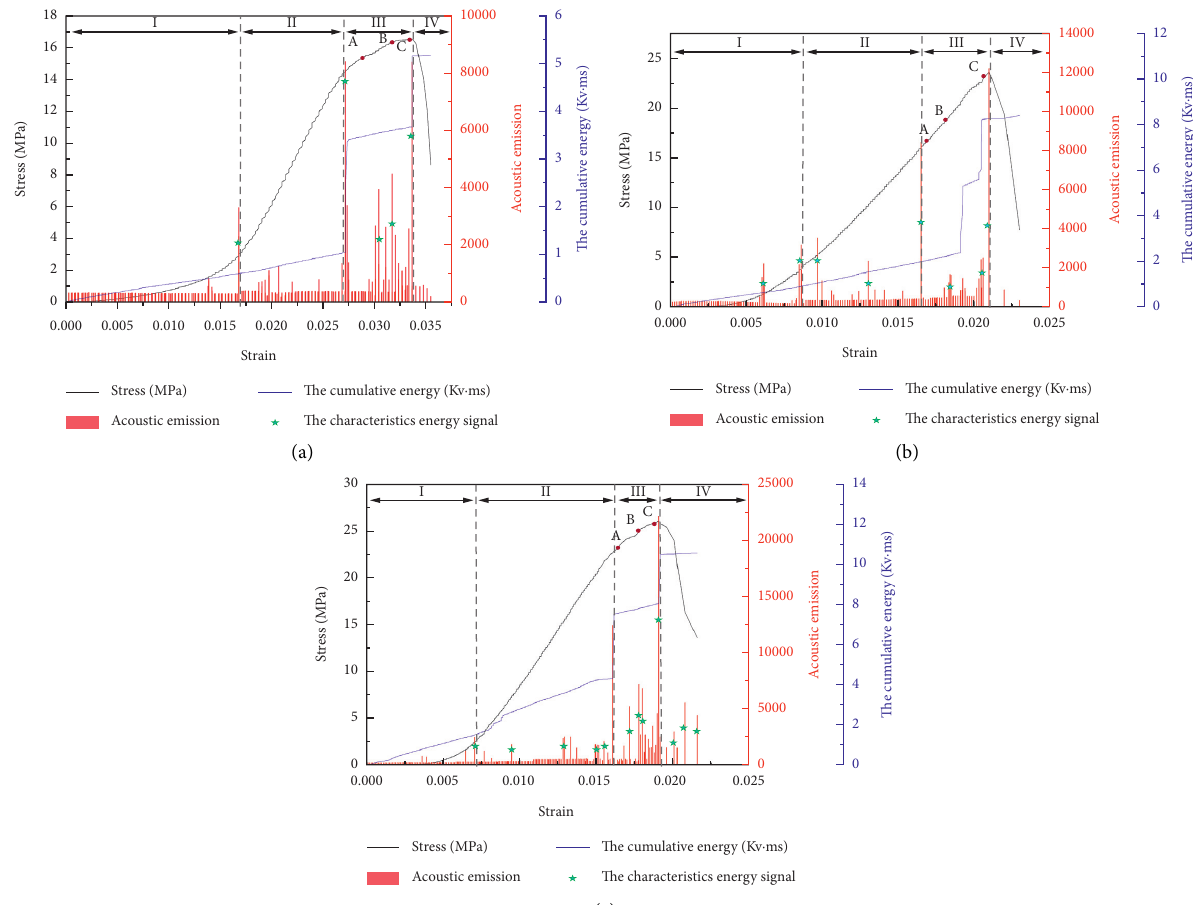
Figure 3: Different coal mass stress-strain and acoustic emission parameters characteristic signals. (a) Sample C (c) sample C 3